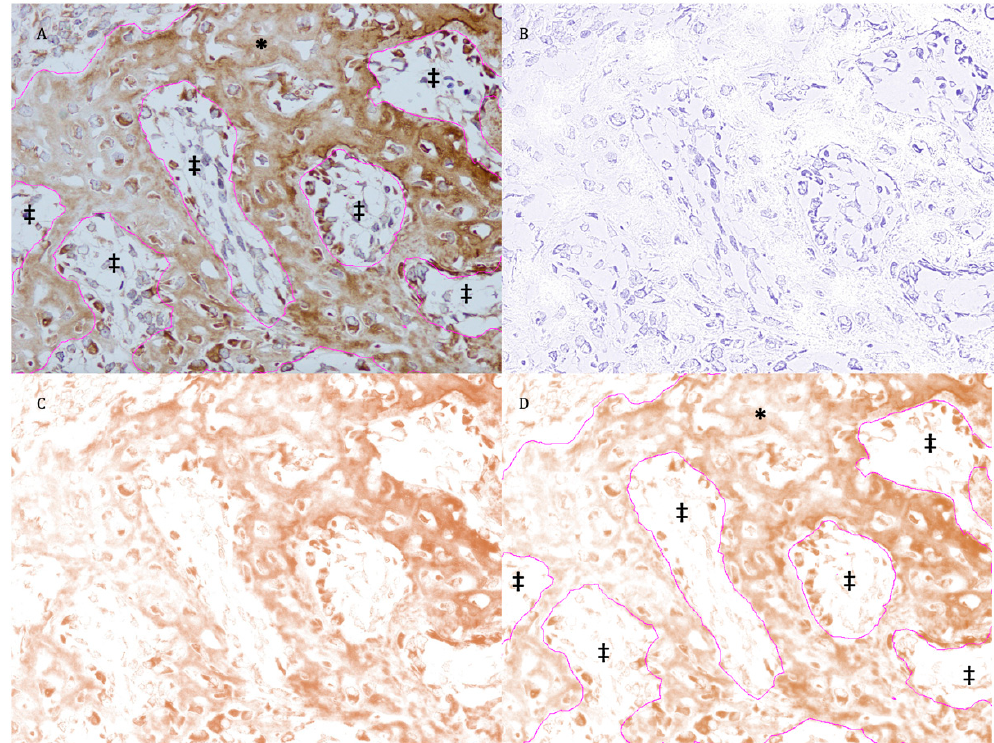
Figure 3. Example new bone area selected as the region of interest. ( A ) Original image with overlay of the selected region of interest. * Selected area; ‡ unselected area. ( B ) Hematoxylin-stained image separated from the original photograph. ( C ) Diaminobenzidine (DAB)-stained image separated from the original photograph. ( D ) Superimposition of the region of interest onto the DAB-stained image. * Selected area; ‡ unselected